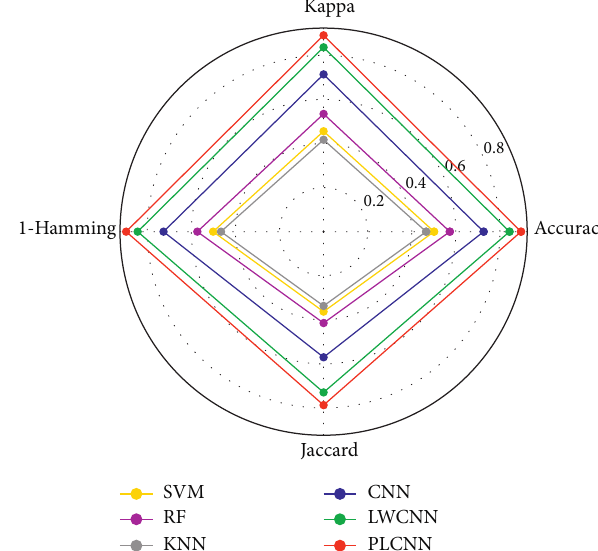
Figure 6: Performance test for Exercise A.